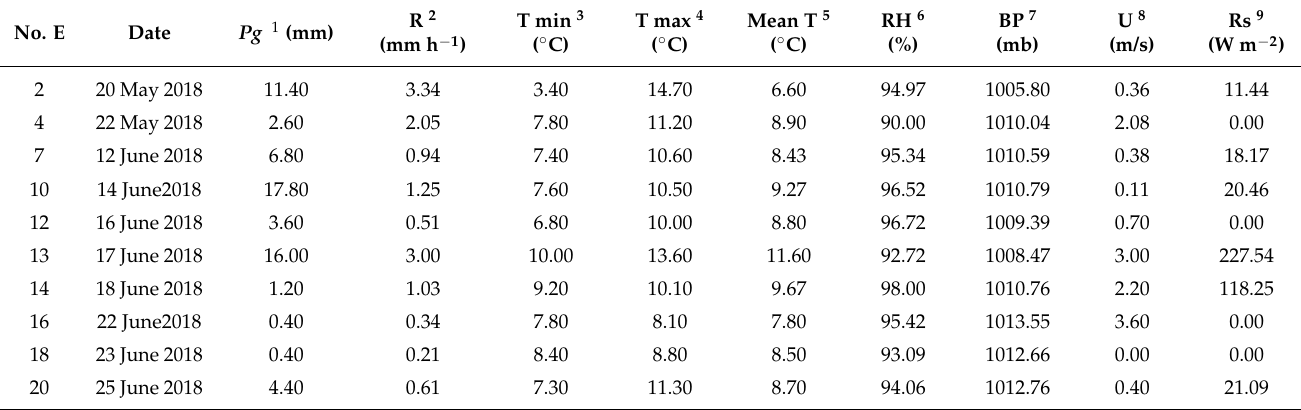
Table 6. Meteorological conditions of the group of precipitation events for the validation of the models. No. E